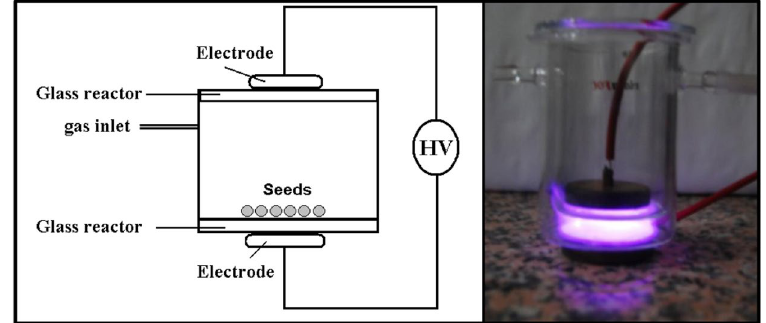
Figure 9. Experimental set-up for atmospheric plasma treatment of nasturtium